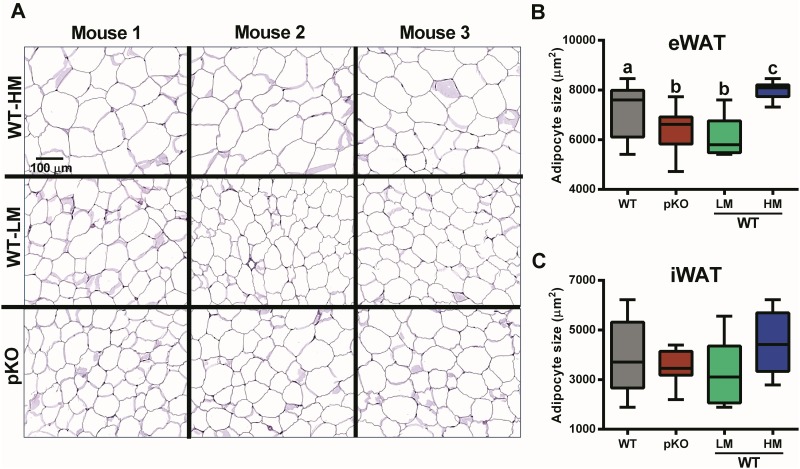
Adipocyte size determination in mice with inactivated Mest.(A) A representative image shows variation in the size of adipocytes in eWAT of WT mice with high (WT-HM; n = 3) and low (WT-LM; n = 3) epididymal adipose tissue (eWAT) Mest expression and MestpKO (pKO) mice (n = 3). (B and C) Box and whisker graphs show the median and range of adipocyte sizes determined morphometrically for WT (n = 17), pKO (n = 10), WT-LM (n = 6) and WT-HM (n = 6) mice for both eWAT and inguinal adipose tissue (iWAT). Significance between groups was determined using two-tailed unpaired parametric t-tests. Datasets annotated with the same letter indicate no significant differences between groups.